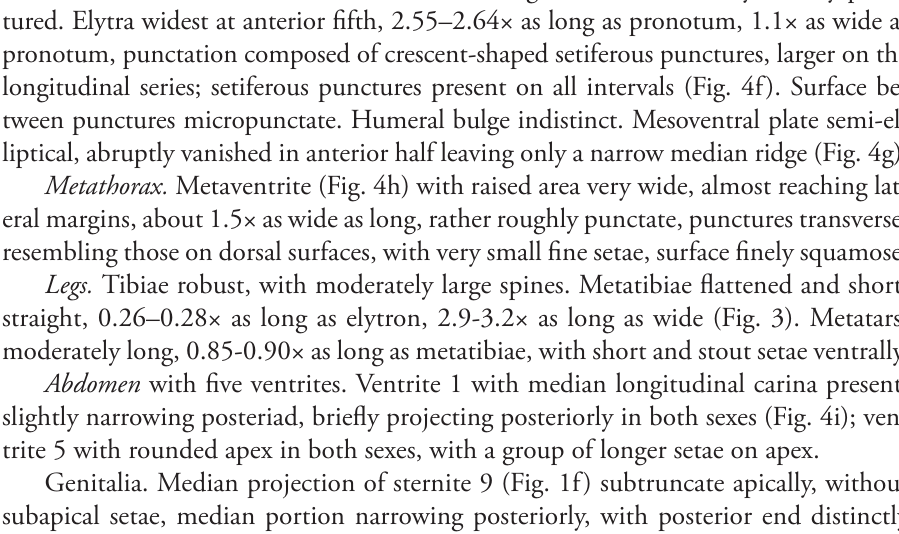
Prothorax. Pronotum transverse, widest at base 1.9× wider than long; 1.45–1.50× wider at base than between anterior angles, 1.8× wider than head including eyes, as convex as elytra in lateral view. Prosternum weakly tectiform medially with anterior margin not thickened or projected ventrally (Fig. 4c). Antennal grooves distinct, weak- ly curved, open posteriorly (Fig.